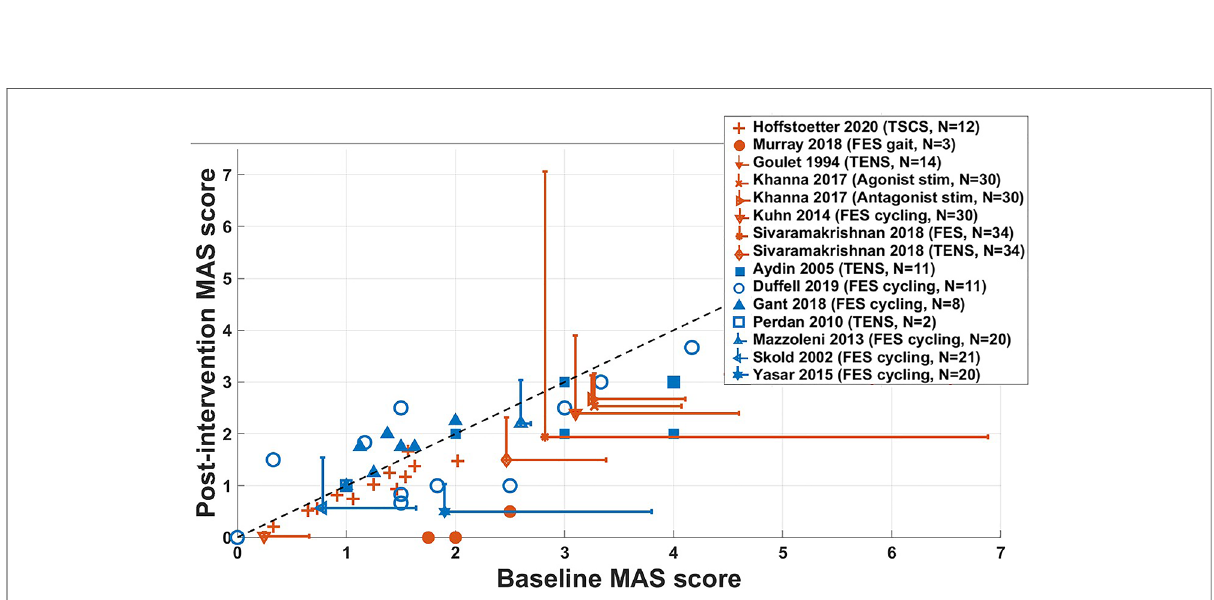
FIGURE 5 Changes in the MAS score of acute (orange, N =112) and long-term (blue, N =93) non-RCT studies. Datapoints with error bars represent studies where data has been presented as mean ± SD and those without show results for individual participants. The dashed line indicates no change in MAS score following intervention. Results for Sköld et al. (2002) represent the combination of averaged MAS scores in knee fl exors and extensors, in left and right legs, which were not measured in every participant, giving N =21. For Yas ̧ ar et al. (2015), averaged MAS scores were measured in knee fl exors and extensors for all participants, giving N =20. Results for Sivaramakrishnan et al. (2018), spasticity was measured in the hip adductors in 19 legs across 10 participants, in 11 legs for the knee extensors and 4 legs for plantar fl exors, giving N =34. FES=functional electrical stimulation, TENS=transcutaneous electrical nerve stimulation, TSCS=transcutaneous spinal cord stimulation.